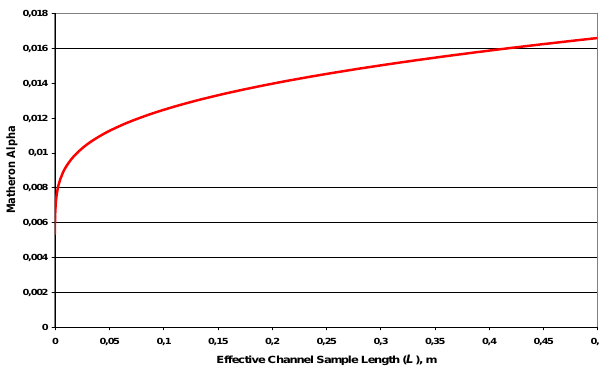
Fig. 10. Constrained least squares estimation of β for L = 0.5m (see Fig. 8) repeated for effective channel sample lengths less than 0.5m. Variogram and autocorrelation functions fitted for distances h> 2m, where absolute dispersion is α = 0.0165, lose validity over shorter distances due to the nugget effect, that results in a decrease in Matheron’s α , especially when L < 0.03m. At the microscopic scale ( h< 0.003m, cf. Fig. 3), α can be expected to increase rapidly